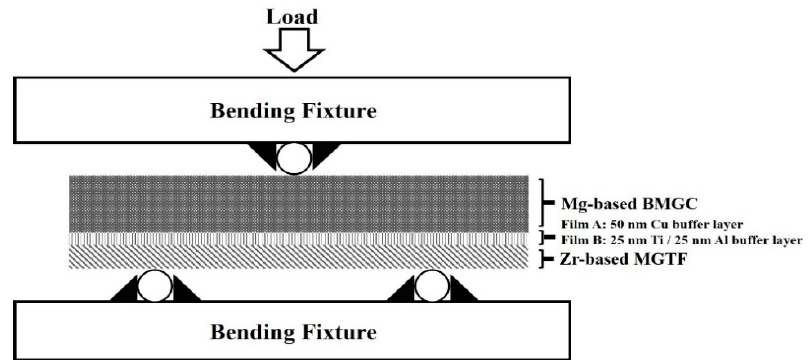
Figure 2. Schematic illustration of three-point bending and sample dimension.